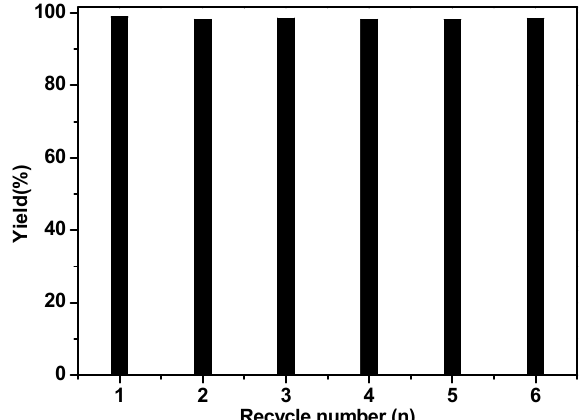
Figure 7. Recycle results of ZIF-8 in the Knoevenagel condensation between 2-nitrobenzaldehyde and malononitrile in biphasic system at 40 ◦ C.